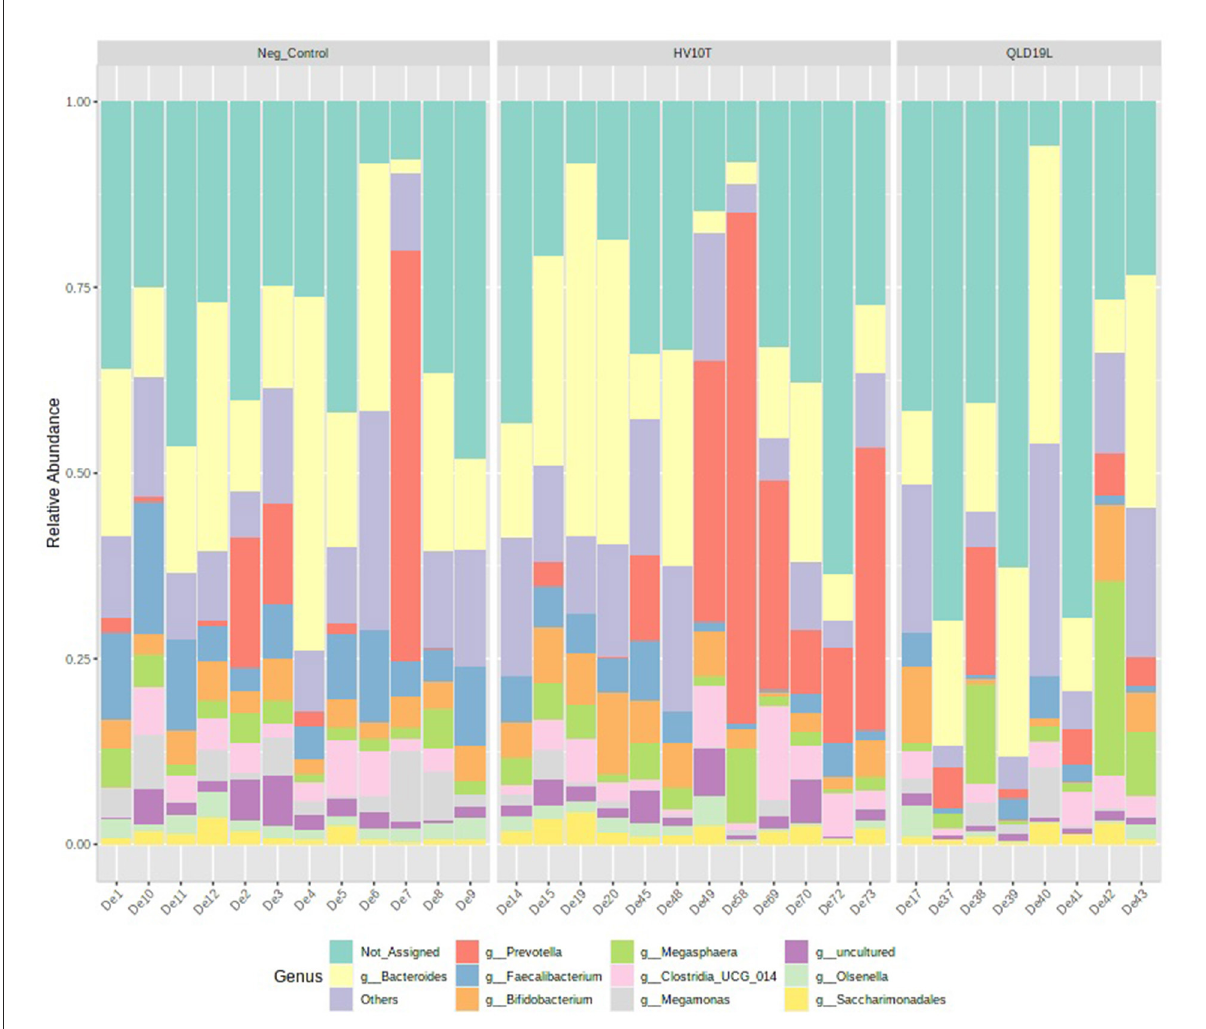
FIGURE6 Relative abundance of top 10 genera detected in caecal content of unchallenged and C. hepaticus HV10 T and QLD19L challenged birds.